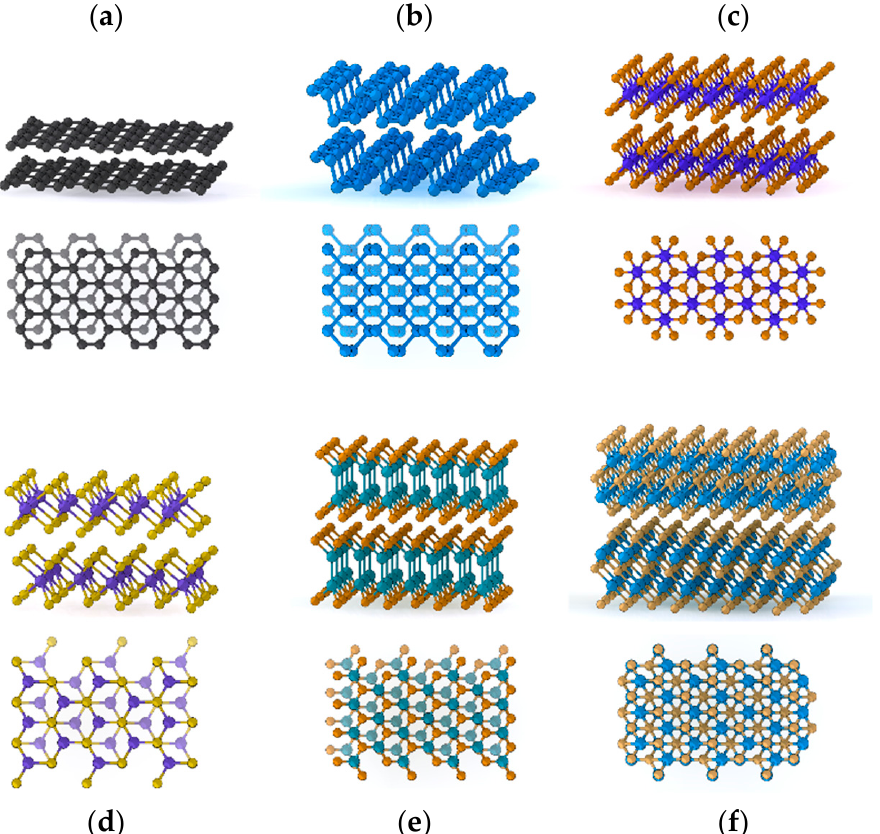
Figure 1. Schematics of a relevant subset of van der Waals materials, which will be discussed in the following review. ( a ) Graphene layers in a Bernal stacking. ( b ) Black phosphorous. ( c ) PtSe 2 in a 1T phase stacking. ( d ) MoS 2 in a 2H phase stacking. ( e ) InSe in a γ phase stacking. ( f ) Bi 2 Te 3 .